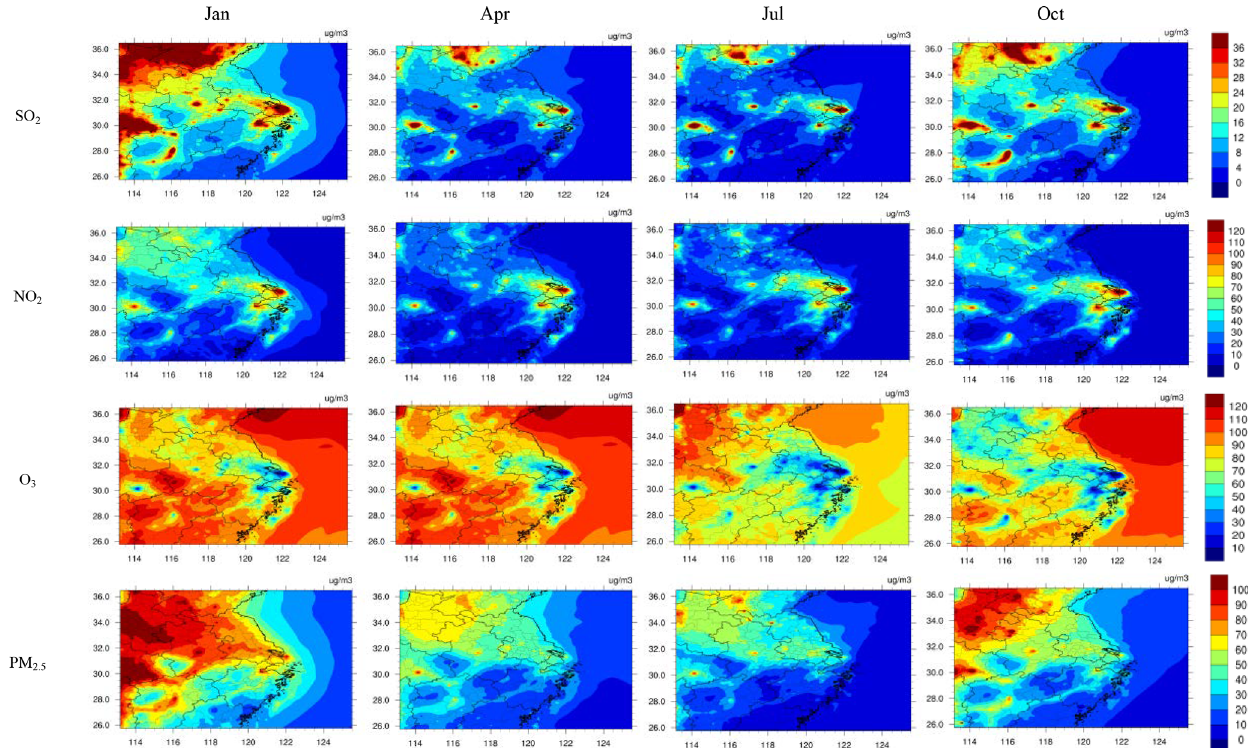
Figure 2. The spatial distributions of the simulated monthly SO 2 , NO 2 , O 3 , and PM 2 . 5 concentrations for case 2 in D2 (unit: µgm − 3 )